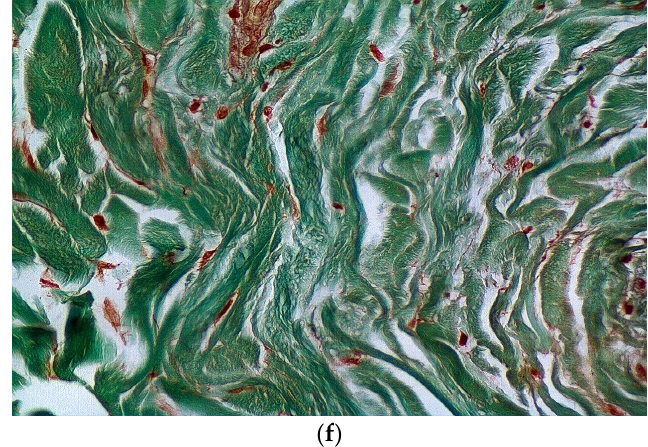
Figure 7. Common and distinctive histologic findings in TSC cutaneous hamartoma. ( a ): Hematein eosin ×10: fibrosis component: extensive fibrosis composed of thick collagen bundles; ( b ): Hematein eosin ×20: vascular component made of dilated vessels and thick collagen bundles; ( c ): Hematein eosin ×40: cellular component: stellate cells; ( d ): Hematein eosin ×10: Concentric perifollicular fibrosis; ( e ): Hematein eosin ×10: Dilated infundibular cyst; ( f ): Orcein staining: decreased or lack of elastic fibers.